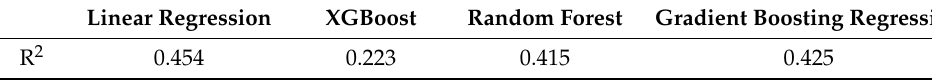
Table 4. Goodness-of-fit of the four model fitting methods.